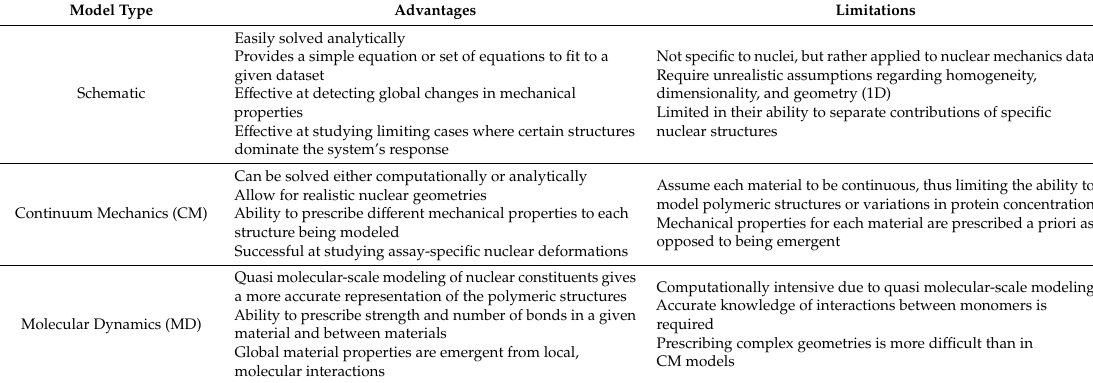
Table 1. A summary of the primary advantages and limitations of the three classes of